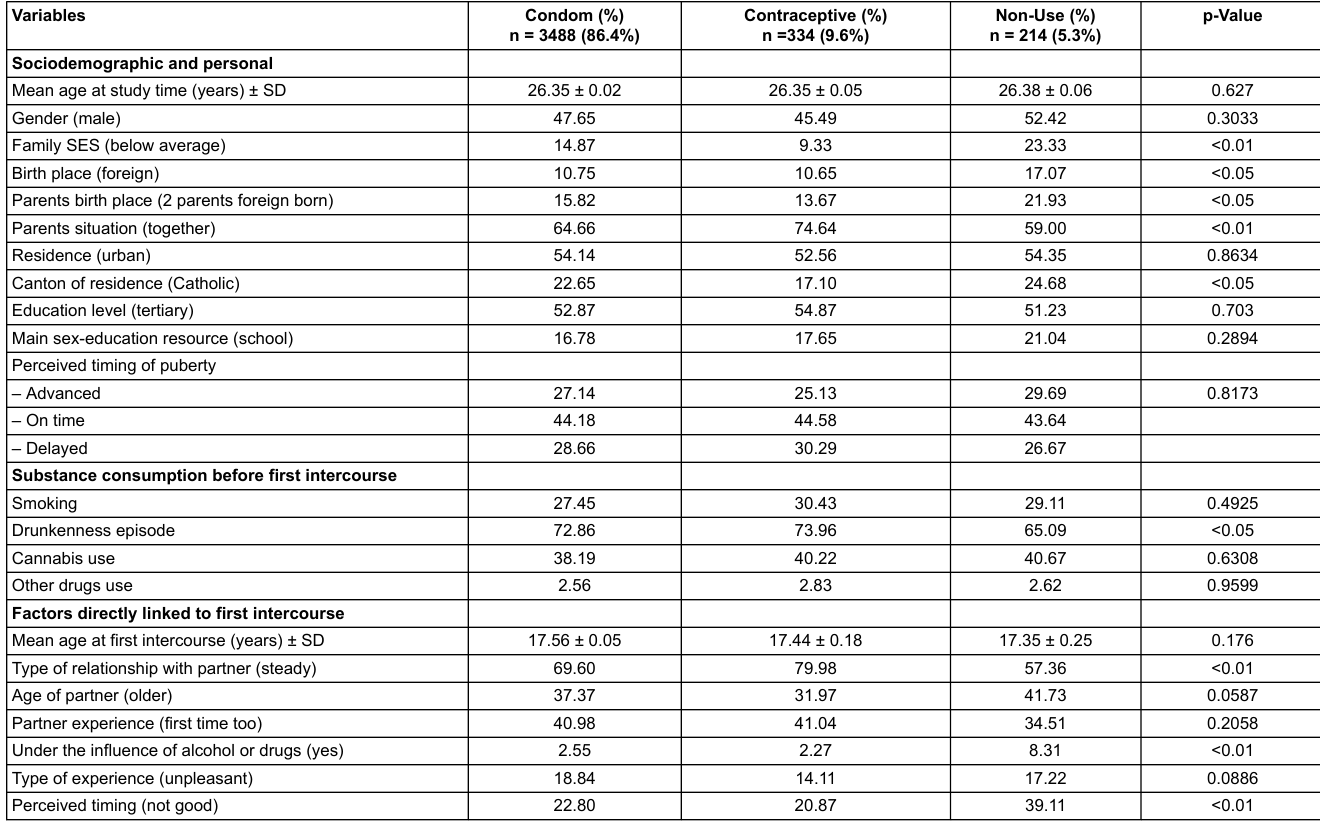
Table 1: Bivariate analysis of sociodemographic and personal characteristics according to contraception used at first intercourse Variables